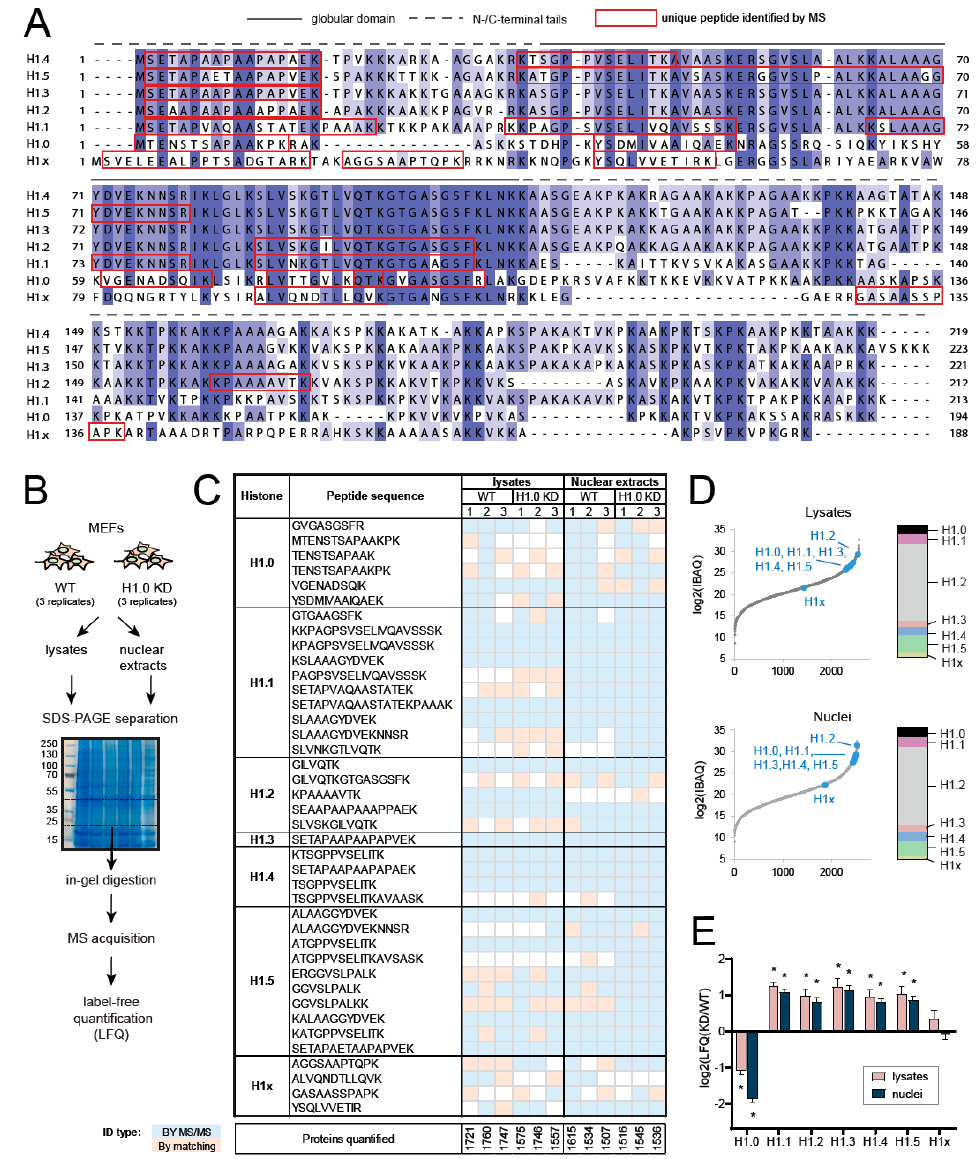
Figure 1. Quantification of histone H1 variants through the MaxLFQ algorithm. ( A ) Sequence alignment of mouse histone H1 variants. Unique sequences detected by MS are marked by red squares. ( B ) Experimental scheme: biological triplicates for protein extracts obtained from mouse embryonic fibroblasts (MEFs) WT, or expressing reduced levels of histone H1 upon shRNA silencing (H1.0 KD), were analyzed by MS. Either lysates or nuclear extracts were loaded on a 4–12% polyacrylamide gel, and a gel band around the size of histone H1 (25–40 kDa) was selected for in-gel digestion with trypsin. ( C ) Unique peptides with up to two miscleavages identified from the samples described in ( B ). Peptides identified in less than three samples are not displayed (refer to Figure S2 for the complete list of peptides). The number of proteins identified and quantified from the same samples is also indicated. White spaces indicate that the peptide was not identified and quantified. ( D ) Intensity-based absolute quantification (IBAQ) scores distribution for proteins quantified from the experiment described in ( B ). The position of histone H1 variants along the distribution is shown, and their relative amounts are shown in the bar on the right. ( E ) Histograms showing the log2 of the label-free quantification (LFQ) fold change observed for histone H1 variants in histone H1.0 KD cells relative to WT cells. Error bars represent the standard error of the mean (SEM) from biological triplicates. * p value < 0.05 by multiple t -test comparison. ID: